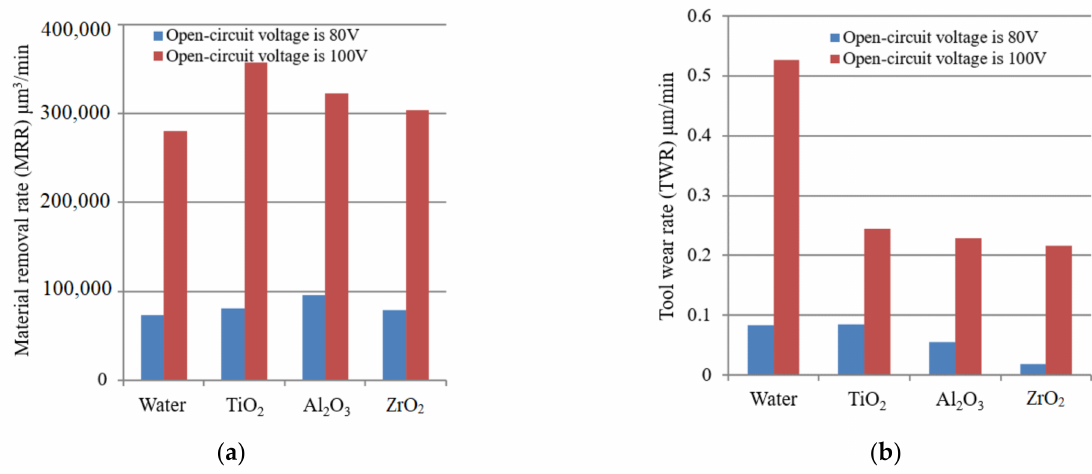
Figure 2. The evolution of MRR and TWR of micro EDM in various dielectric. ( a ) MRR, ( b )